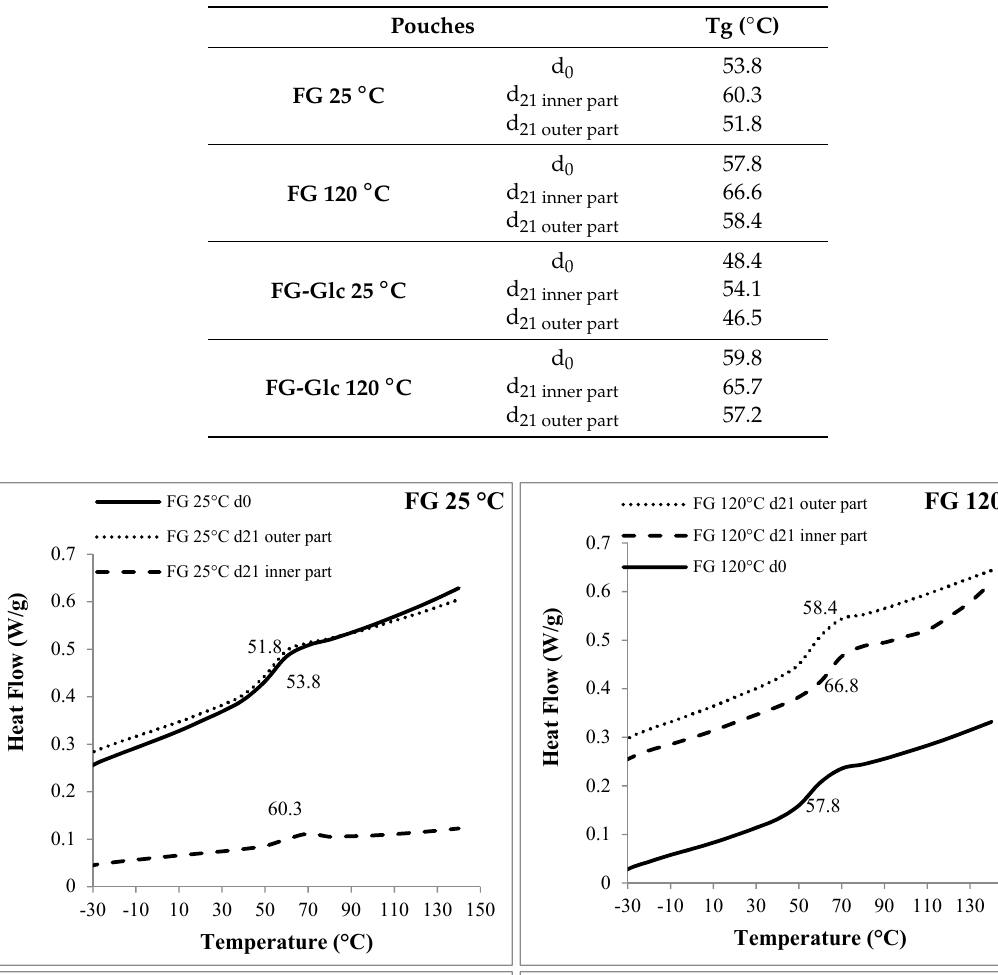
Table 3. Glass transition temperature (Tg) of the FG and FG-Glc pouches at the initial time (d 0 ) and 21 days after application (d 21 ). The inner part consists of the film sample in contact with the oil, whereas the outer part is not in contact with the oil. The average relative error of the data is about 10%.